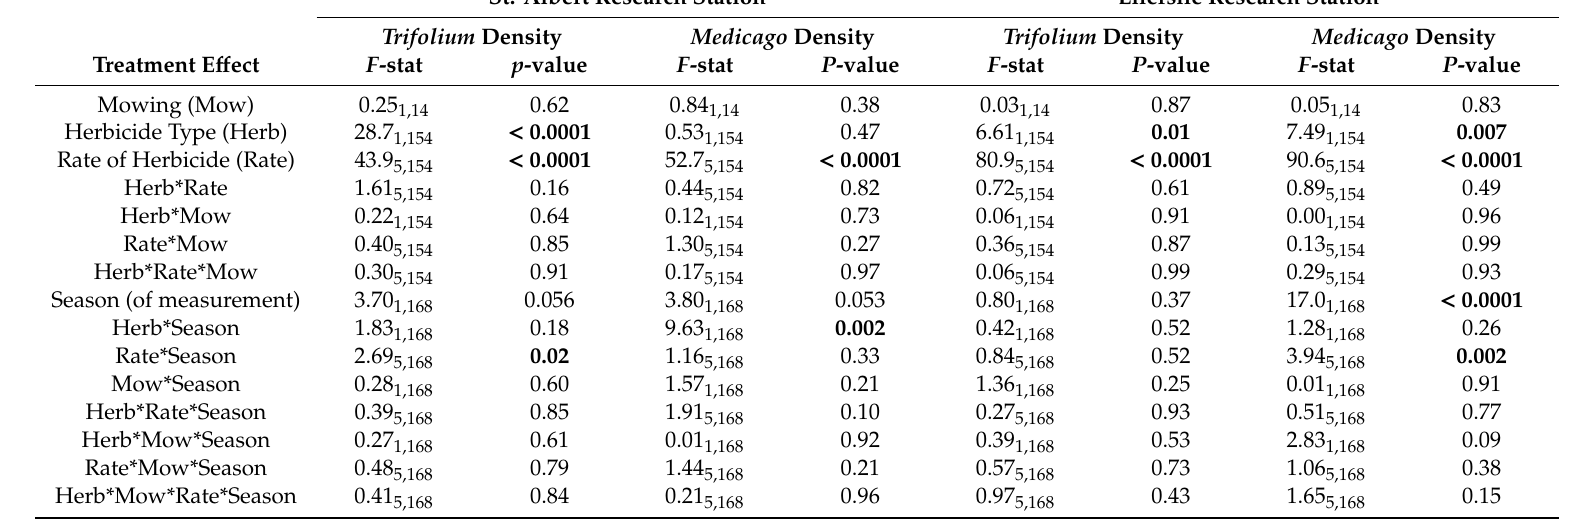
Table 3. Summary of F-statistic and significance values associated with clover and alfalfa plant densities from over-seeded grasslands at each of the St. Albert and Ellerslie study sites, following di ff erent types of herbicide application at six di ff erent rates, under mowed and nonmowed conditions. Data represent measurements taken in summer and fall after spring seeding, and within two duplicate trials in consecutive years. All analyses done on log transformed data to similar clover densities between the 0, 0.0625, and 0.125